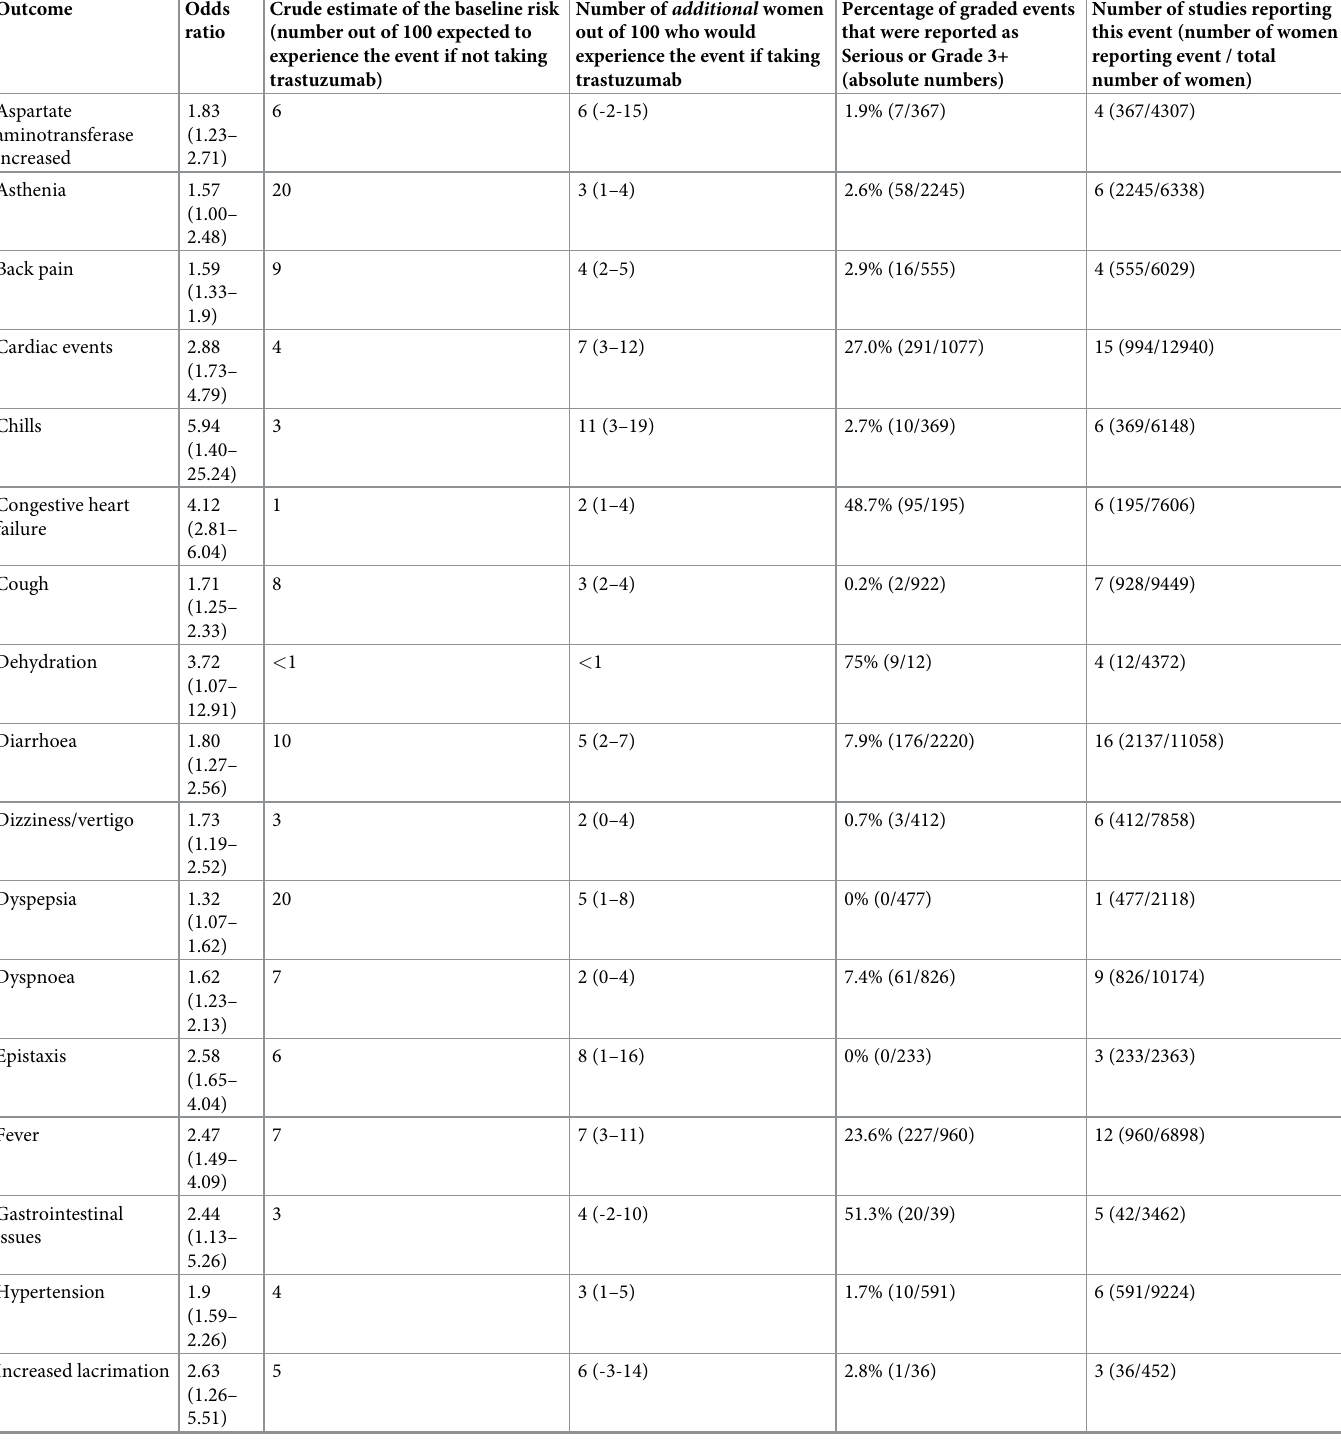
Number of additional women Percentage of graded events Number of studies reporting out of 100 who would that were reported as this event (number of women experience the event if taking Serious or Grade 3+ reporting event / total trastuzumab (absolute numbers) number of women)